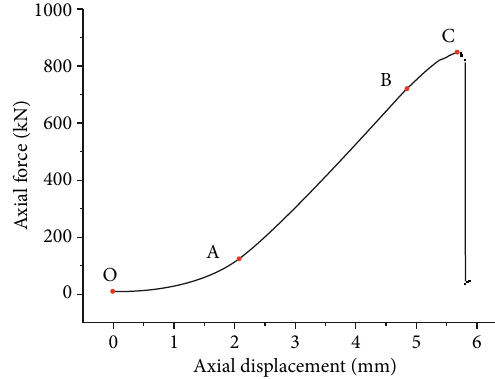
Figure 3: Curve of axial force versus axial